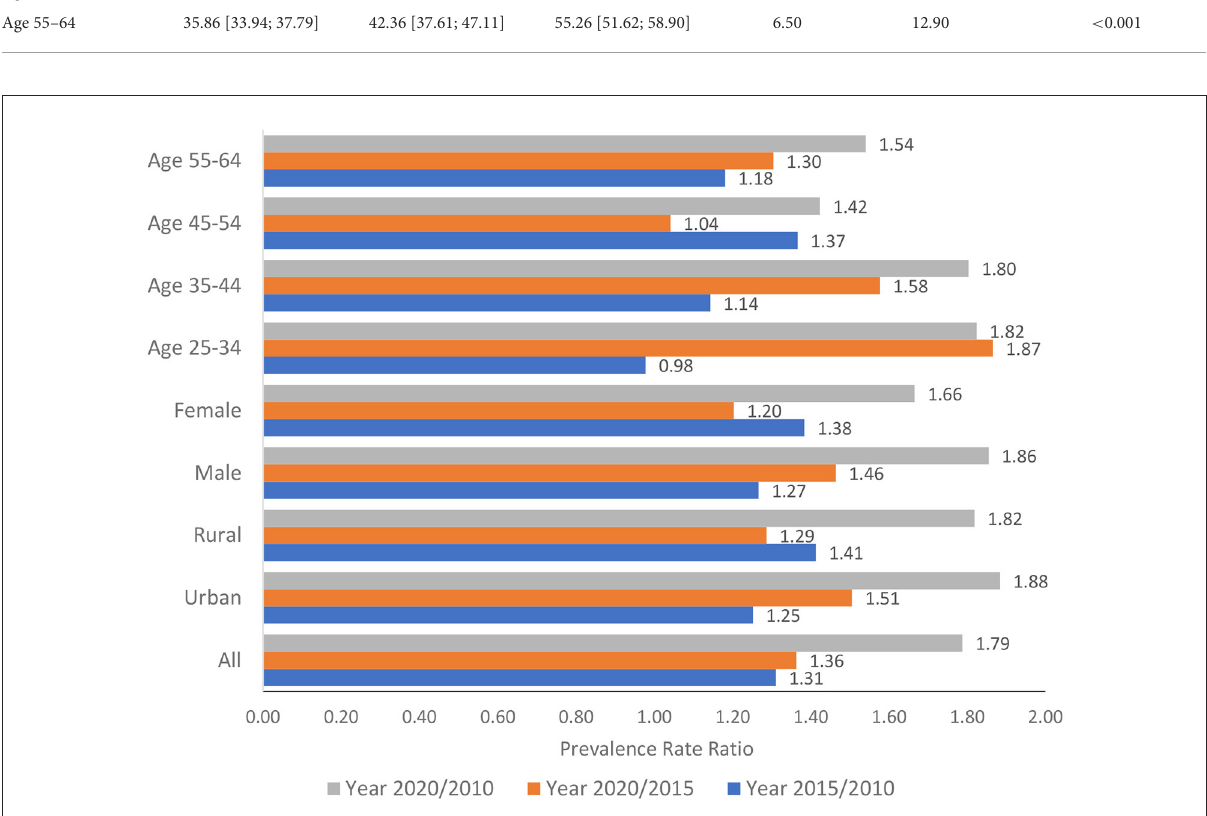
FIGURE1 Relative changes in the prevalence of raised blood pressure among the population aged 25–64 years over